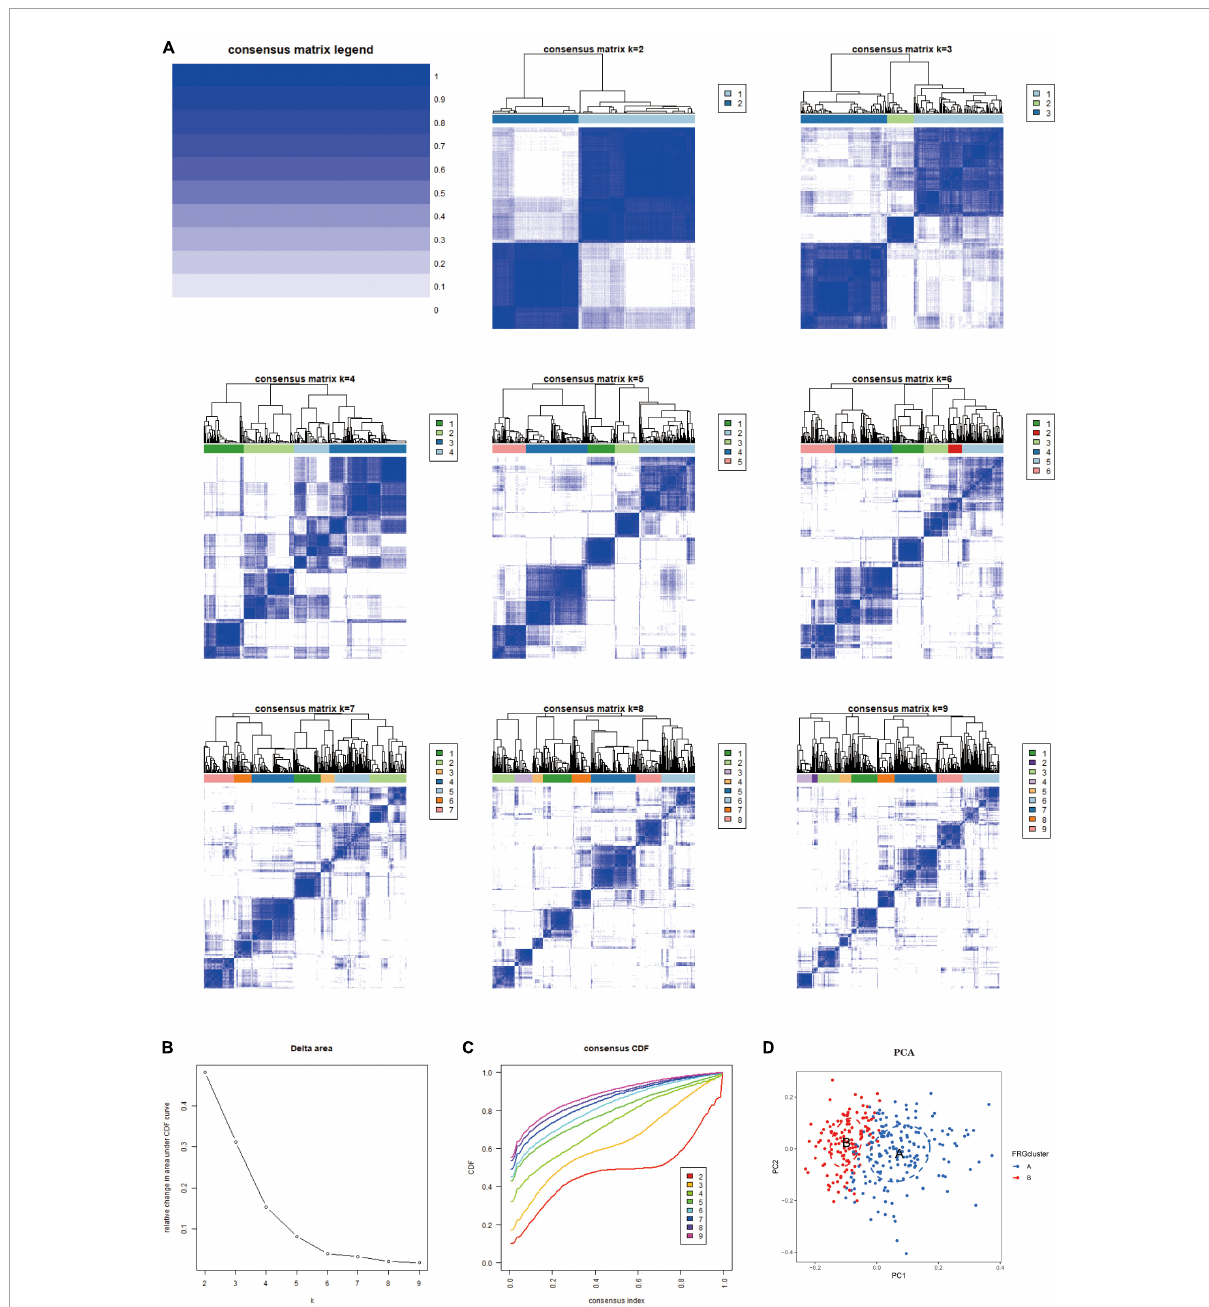
FIGURE4 The results of 2 clusters of patients with AD. (A) Heatmap of consensus clustering for k = 2–9. Colour gradients indicate from 0 to 1 (white: 0, blue: 1). (B) Delta represents the relative change course in the area under the CDF curve when k = 2–9. (C) Cumulative distribution function (CDF); (D) PCA results of the expression profiles of the two FRGcluster patterns, showing the marked differences in the transcriptomes between the different FRGclusters. The red dots in the scatter plot represent FRGcluster A, and the blue dots represent FRGcluster B. CDF, cumulative distribution function; FRGcluster, Ferroptosis-related gene